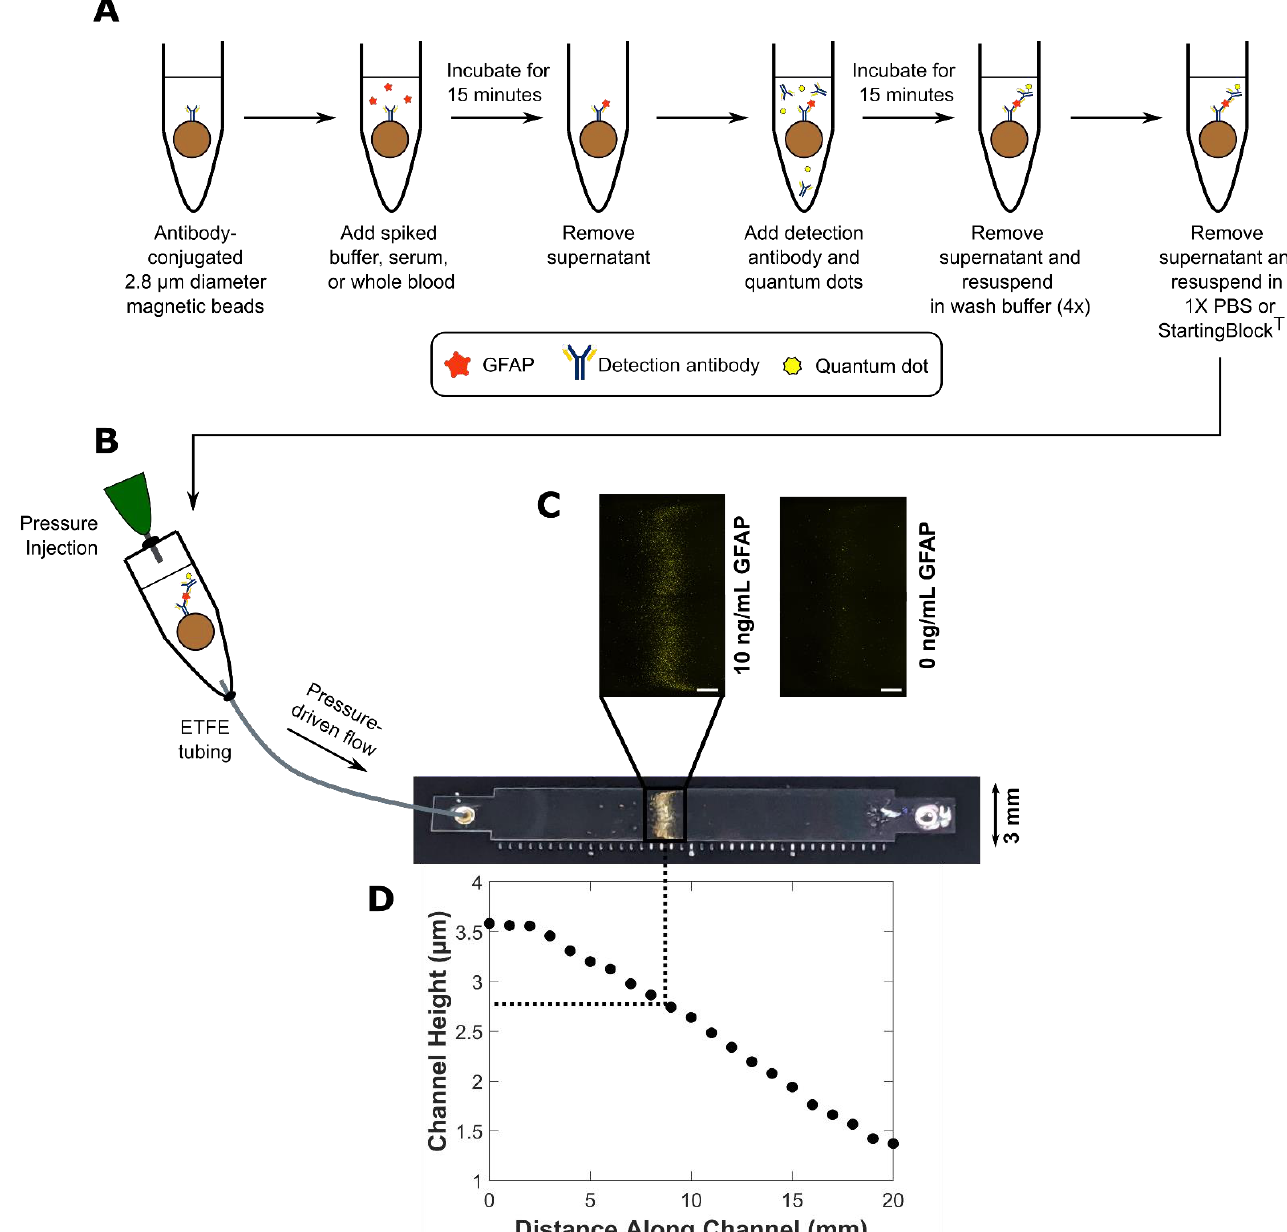
Figure 1. Schematic of the method used to run and analyze bead-based quantum dot-linked immunosorbent assays (QLISAs) for glial fibrillary acidic protein (GFAP) (pictured) as well as interleukin-6 (IL-6) and interleukin-8 (IL-8). ( A ) The binding steps necessary to complete the sandwich assay were performed on the benchtop in a microcentrifuge tube. Note that a single bead is pictured with a single antibody for the sake of clarity, but the assay consisted of millions of beads completely coated in antibodies. ( B ) The bead mixture with completed sandwich complexes was introduced into the variable height device using a modified microcentrifuge tube and pneumatic pressure. ( C ) The beads formed fluorescent bands inside the variable height device where the fluorescence intensity is related to the protein concentration in the sample (white scale bar 500 µm). ( D ) The channel height varies between the inlet and outlet, so the assay beads become trapped where their diameter matches the height of the channel (graph is of a representative height profile obtained using a stylus profilometer).